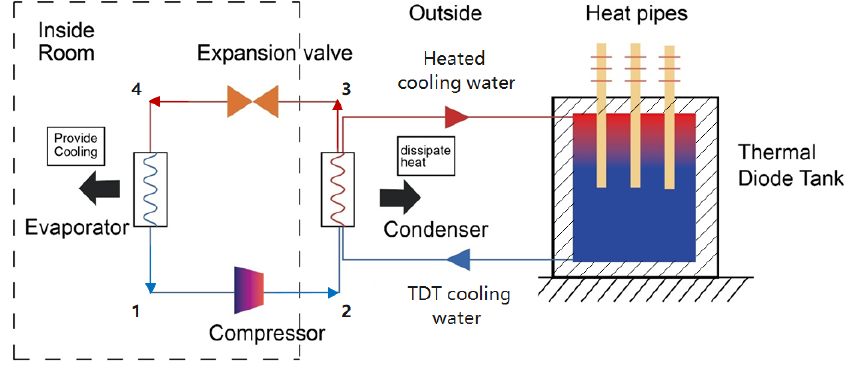
Figure 3. Schematic diagram of a TDT-RAC system.